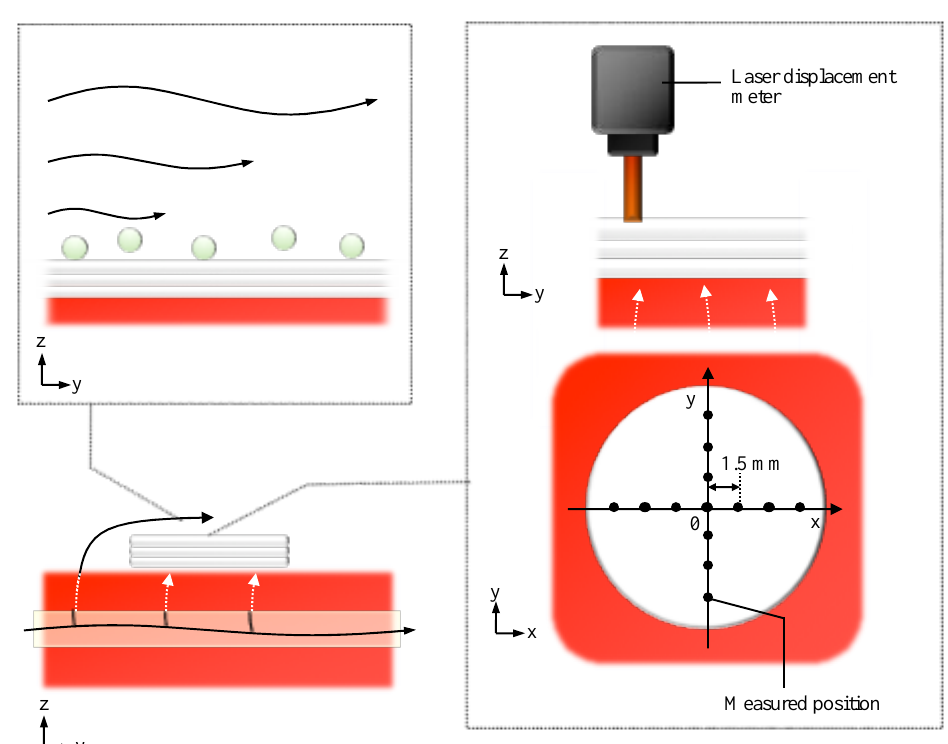
Figure A2. The densities of the cell tissue cultured for three days. HE-stained cross-section views with the cell tissue culture on a general dish ( A ) and collagen gel with a 0.5-mL/min perfusion rate ( B ). Images of 1 and 2 were taken from different samples, and the sample is as shown in Figure 3. Scale bars indicate 100 µm.